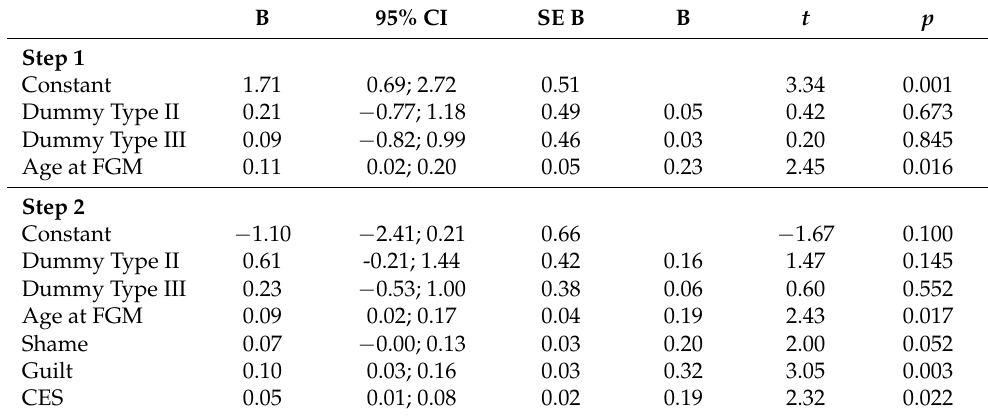
Table 3. Predictors for